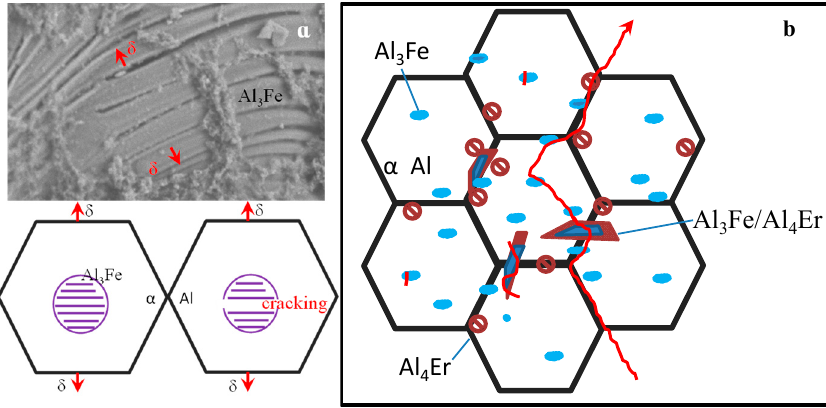
Figure 7. Schematic of the crack propagation in Al 3 Fe ( a ) and in alloy ( b ).